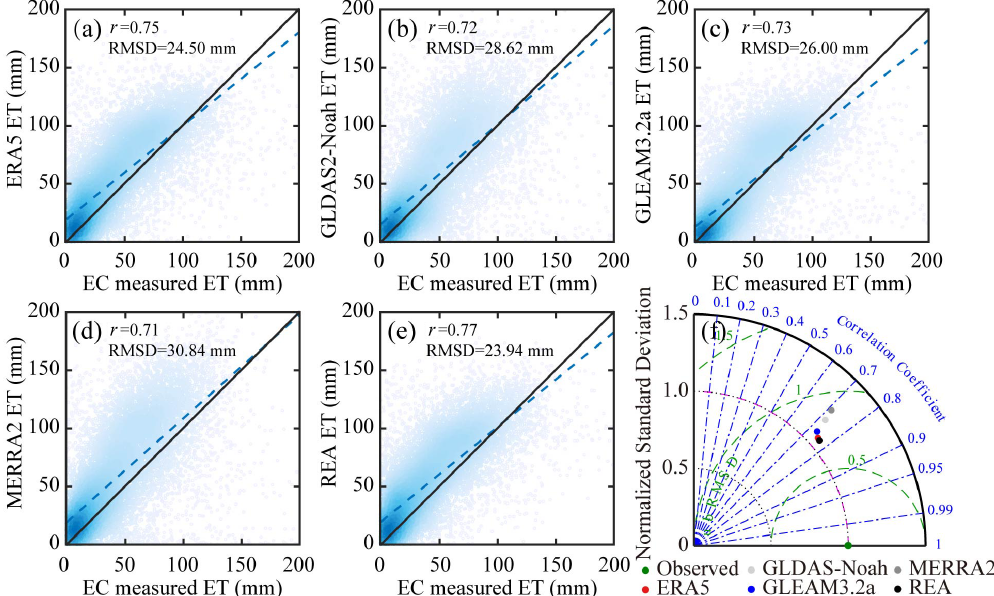
Figure 6. (a–e) Scatterplots and (f) Taylor diagrams of monthly ground-measured ET and ET from different products. Linear fits are plotted in blue, and the 1 : 1 line is depicted. The correlation coefficients ( r ) have passed the 5% significance